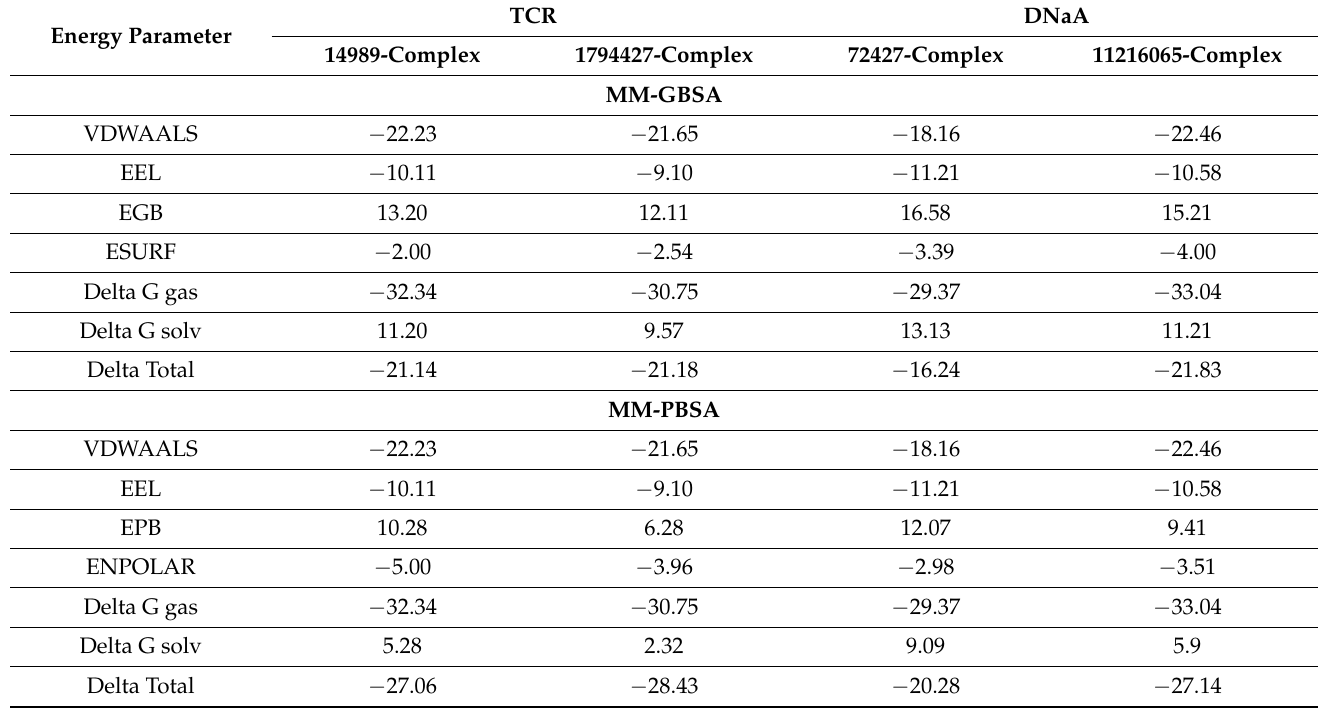
Table 6. Binding energies of the target proteins. All values are given in